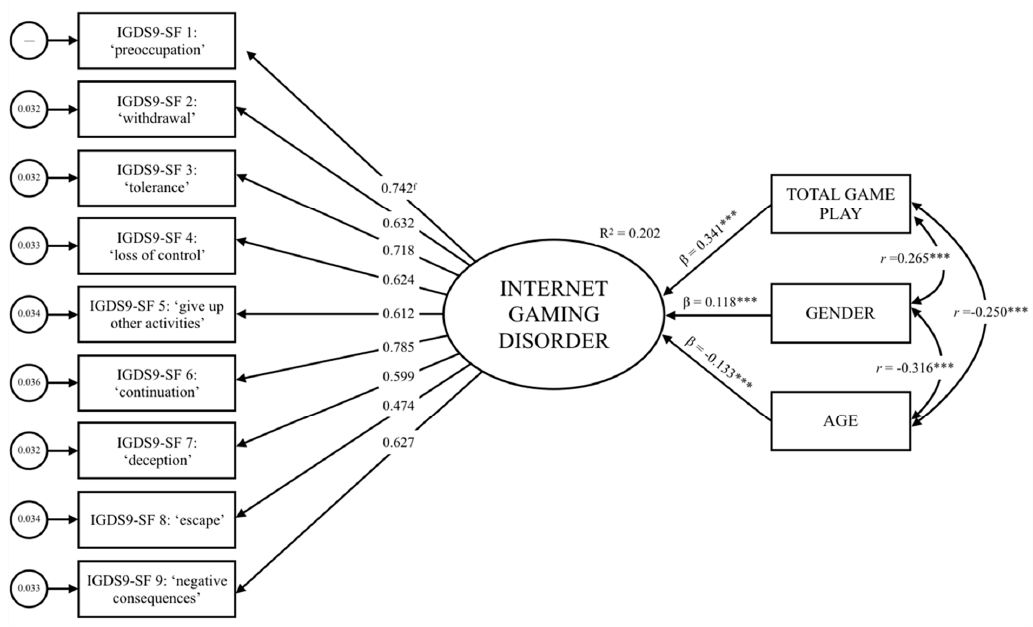
Figure 1. Graphical summary of the validity analysis if the Internet Gaming Disorder (IGD) construct.